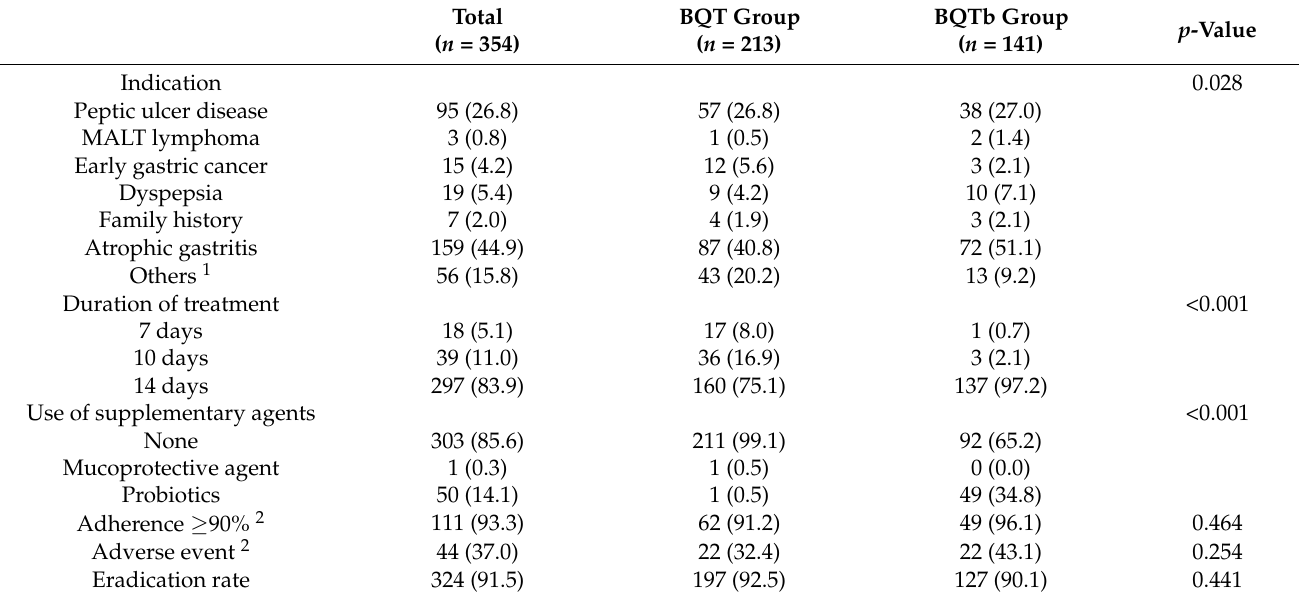
Table 2. Characteristics associated with eradication